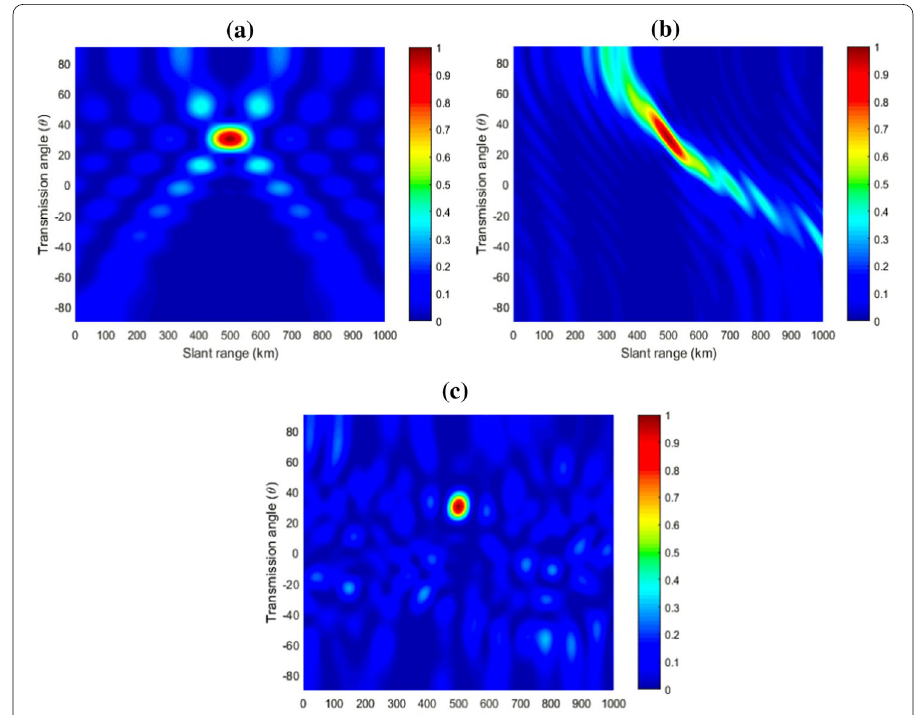
Fig. 8 Beampattern synthesis results. a Hamming FDA. b Log‑FDA. c Piecewise